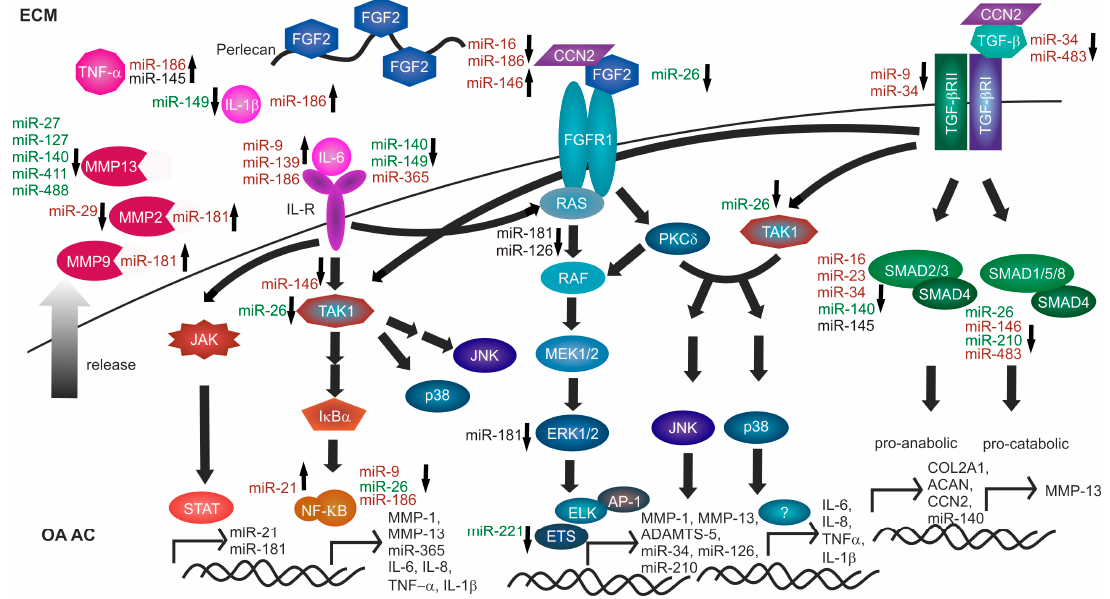
Figure 2. FGF2, TGF ‐β and inflammatory cytokine induced catabolic and pro ‐ inflammatory signaling in human OA AC. The major components of inflammatory cytokine, FGF2 and TGF ‐β activated nuclear factor kappa B (NF ‐κ B), mitogen activated protein kinase (MAPK), and SMA ‐ and MAD ‐ related protein (SMAD) signaling as well as their transcriptional targets in human OA AC are depicted. Micro RNAs (miRNAs) upregulated in human OA AC are indicated in red, miRNAs downregulated in human OA AC are indicated in green. For miRNAs with contradictory regulation a black font is chosen. The small arrows beside the miRNAs pointing downwards indicate direct or indirect inhibition of the signaling component by the miRNA, whereas small upward arrows indicate direct or indirect activation of the signaling component by the miRNA. As illustrated, there is an intense crosstalk between the individual pathways. In human OA AC, expression of pro ‐ catabolic target genes is mediated by NF ‐κ B, MAPK and SMAD signaling, whereas pro ‐ inflammatory targets are activated downstream of MAPK and NF ‐κ B signaling. Advanced stages of OA are characterized by activation of inflammatory cytokine signaling. On miRNA level there is primarily a net upregulation of IL ‐ 6, whereas both positive and negative regulation of NF ‐κ B signaling is reported. Moreover, in human OA AC upregulation of CCN2 and significantly enhanced activation of extracellular signal ‐ regulated kinase (ERK), JUN N ‐ terminal kinase (JNK) and p38 MAPK pathways has been documented. Yet, evidence for ERK signaling regulation by miRNA is contradictory, whereas JNK and p38 activation is a common downstream event after inflammatory cytokine, FGF2 and TGF β pathway activation with no direct miRNA regulation reported in OA AC to date. TGF ‐β signaling is globally downregulated in OA AC with especially negative regulation of the anabolic SMAD3 mediated pathway which is both evident on protein and miRNA level. In addition, in particular at miRNA level, reversal of negative regulation of MMP ‐ 13 is obvious in OA AC.